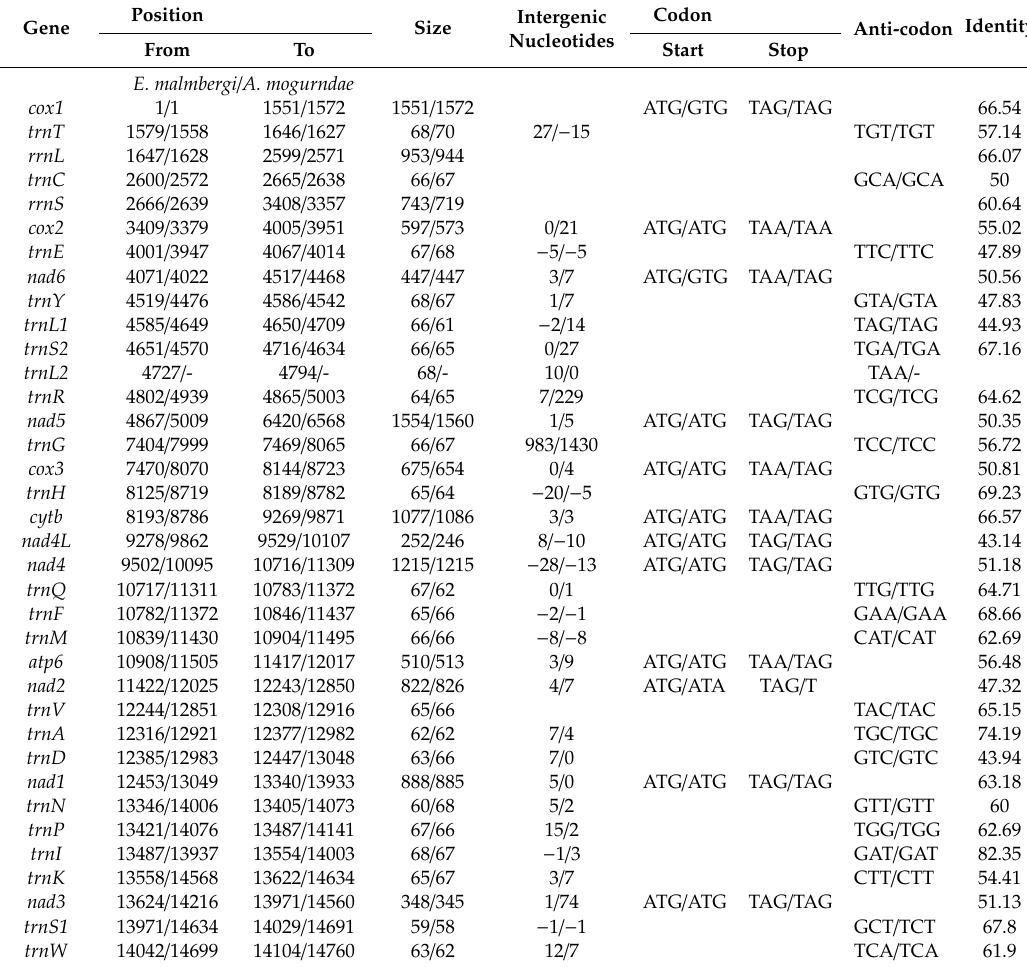
Figure 1. Visual representation of the circular mitochondrial genomes of A. mogurndae and E. malmbergi . Protein-coding genes are red, tRNAs are yellow, rRNAs are green, and non-coding regions are grey. Table 1. Comparison of the annotated mitochondrial genomes of Ancyrocephalus mogurndae and Enterogyrus malmbergi .